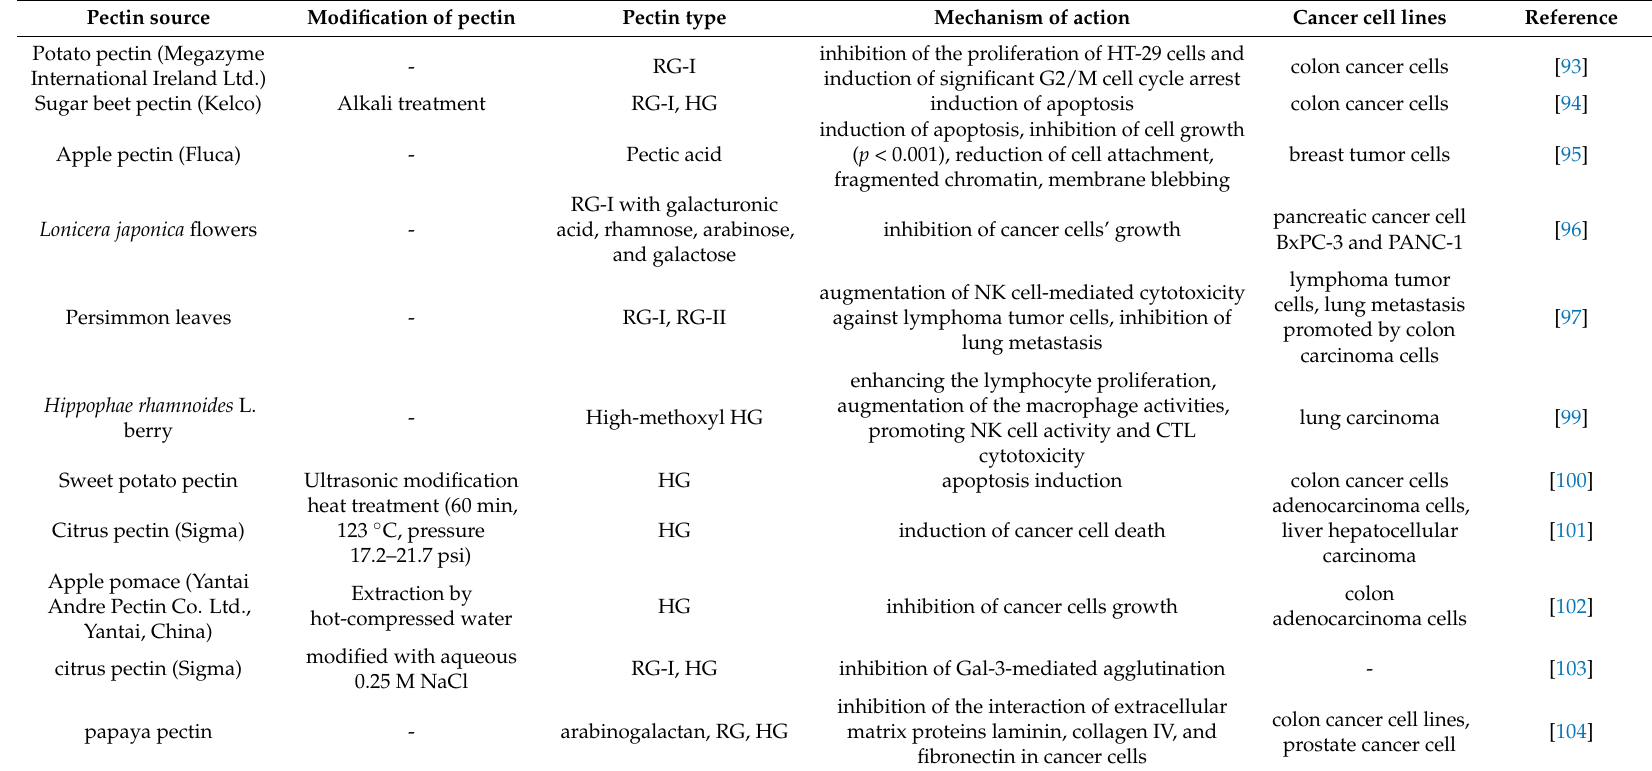
Table 3. Antitumor activity of pectins. Gal: galactose, NK: natural